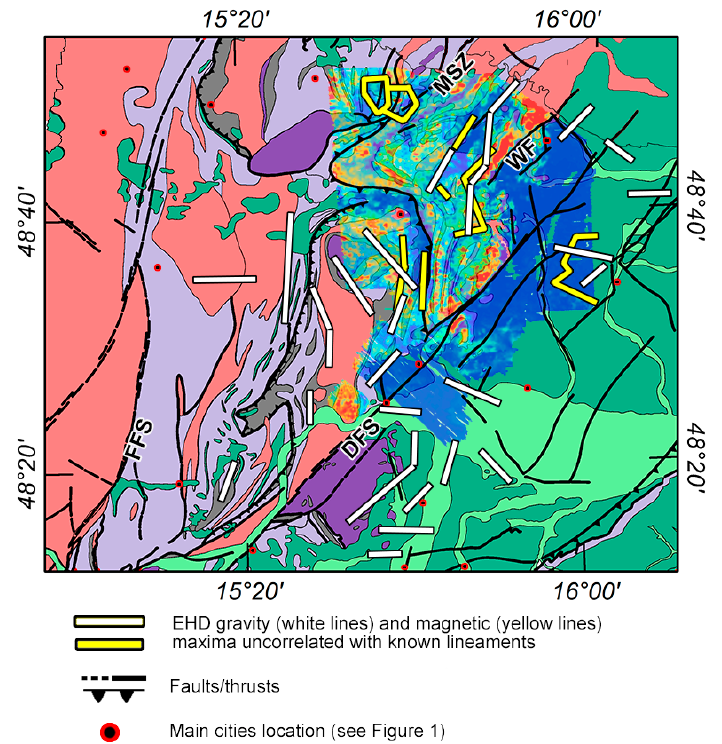
Figure 10. Correlation between geology (refer to Figure 1), resistivity values deriving from the EM measurements (colored contouring) and the main maxima of the medium-scale EHD function on gravity (white lines) and magnetic (yellow lines) data. West of the DFS, the identified lineaments correlate generally well with faults, thrusts, or contacts between mapped geological units. Eastward, in the Molasse Basin, the correlation is not as obvious, but the Neogene sedimentary infill of the Molasse Basin covers deeper seated structures; therefore, these could be newly discovered faults or geological